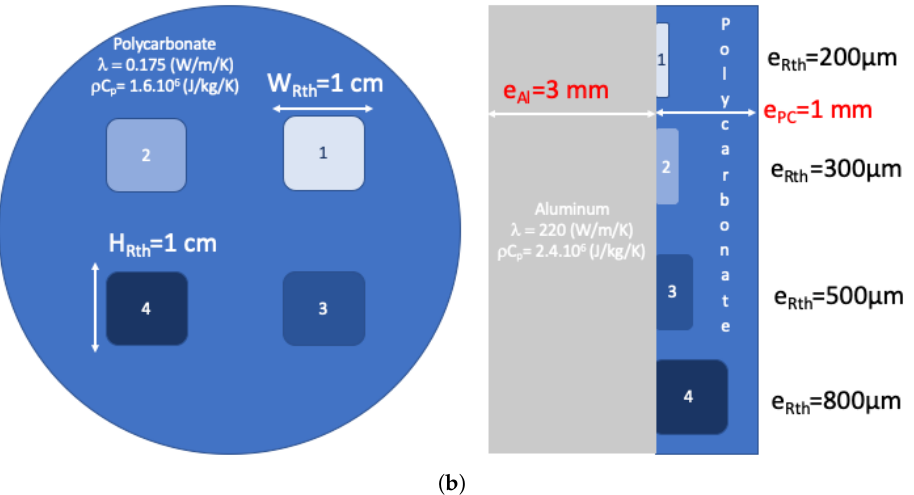
Fig. 2: a) Photograph of the polycarbonate layer and b) schema of the reference sample used in this Figure 2. ( a ) Photograph of the polycarbonate layer and ( b ) schema of the reference sample used in study this study.